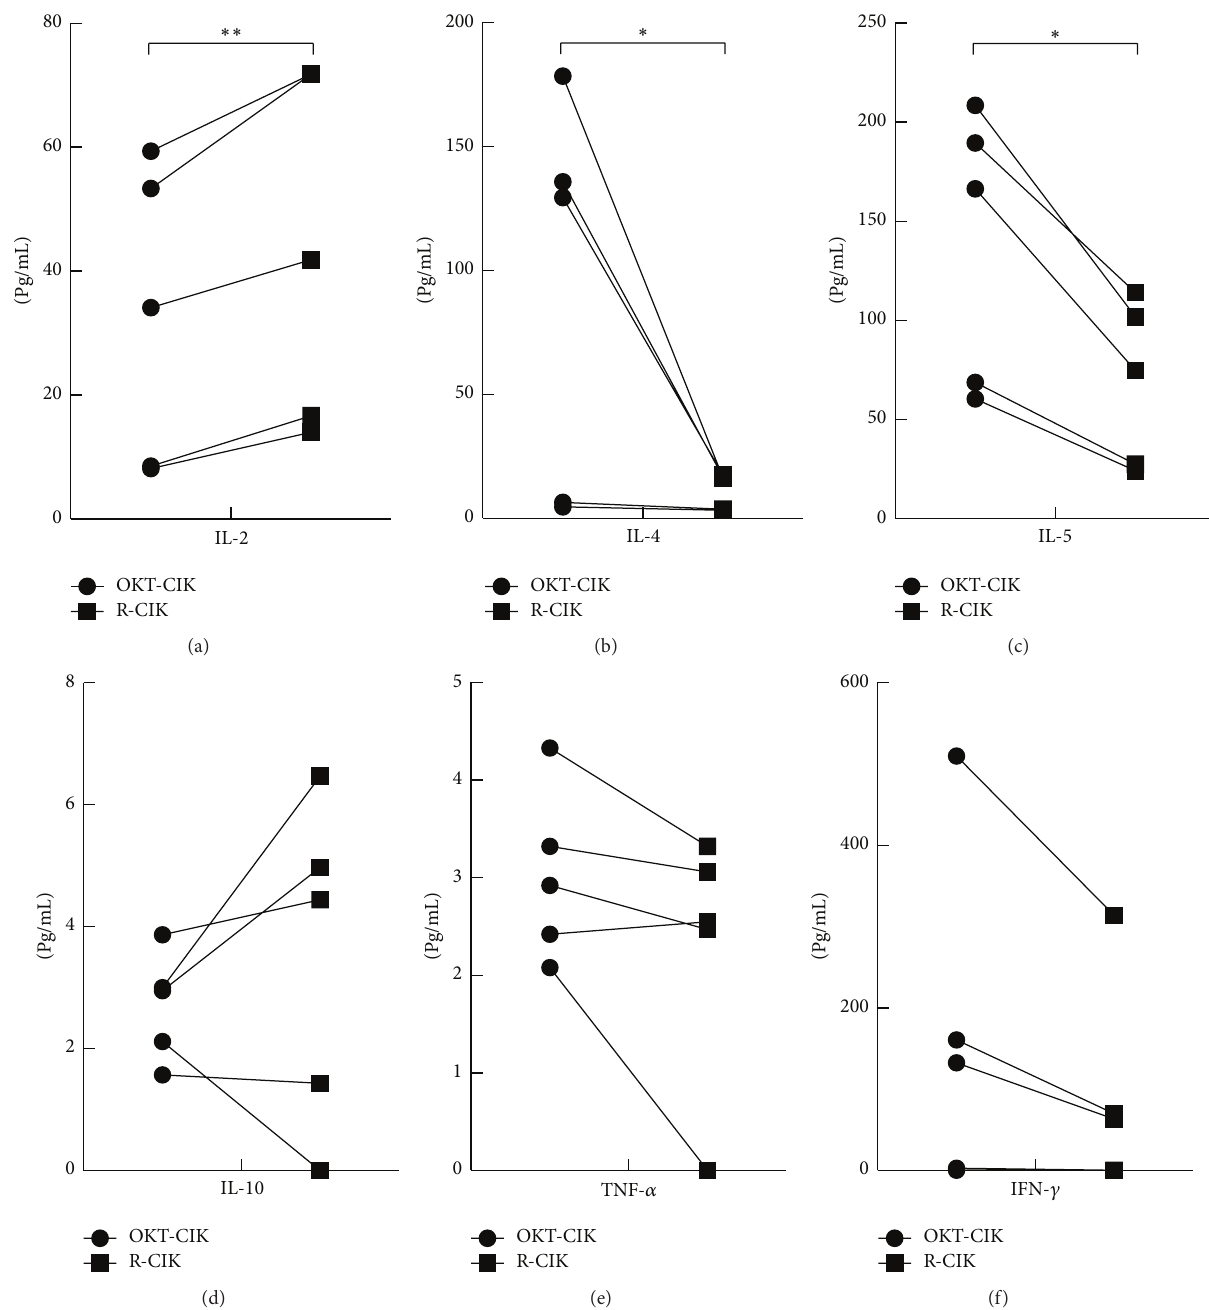
Figure 3: Cytokine secreted by OKT-CIK and R-CIK cells. (a) IL-2 was secreted by OKT-CIK and R-CIK cells. (b) IL-4 was secreted by OKT- CIK and R-CIK cells. (c) IL-5 was secreted by OKT-CIK and R-CIK cells. (d) IL-10 was secreted by OKT-CIK and R-CIK cells. (e) TNF- 𝛼 was secreted by OKT-CIK and R-CIK cells. (f) IFN- 𝛾 was secreted by OKT-CIK and R-CIK cells. R-CIK cells secreted higher IL-2, while they secreted lower level of IL-4 and IL-5. There was no difference between the OKT-CIK and R-CIK cells when compared to IL-10, TNF- 𝛼 , and IFN- 𝛾 ( 𝑃 > 0.05 ). ∗ 𝑃 < 0.05 ; ∗∗ 𝑃 < 0.01 for the comparison, 𝑛 = 5